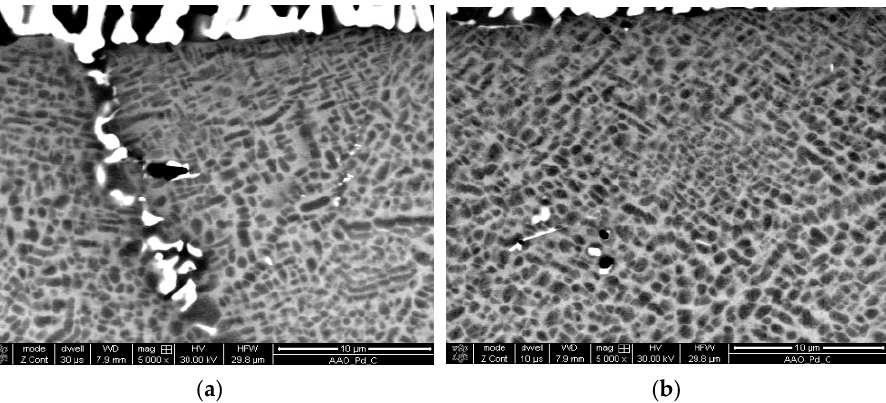
Figure 5. Phase γ ’ precipitation morphology—temperature of 1323 K for: ( a ) 2 h, ( b ) 3 h (Reprinted with permission from Ref. [2]. 2012, AFIT.).